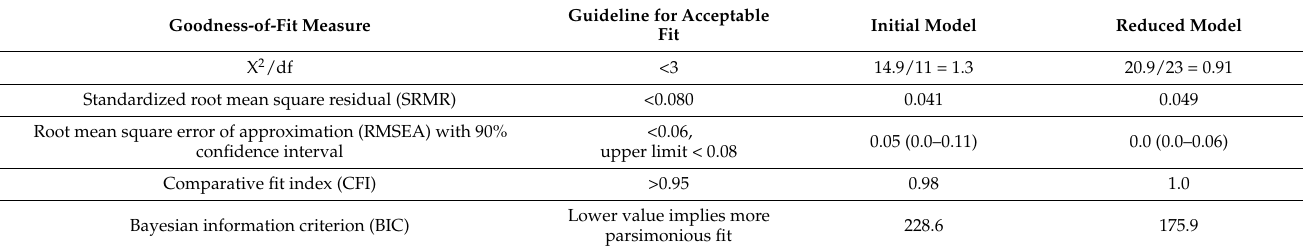
Table 1. Goodness of fit indices of the initial and reduced models.